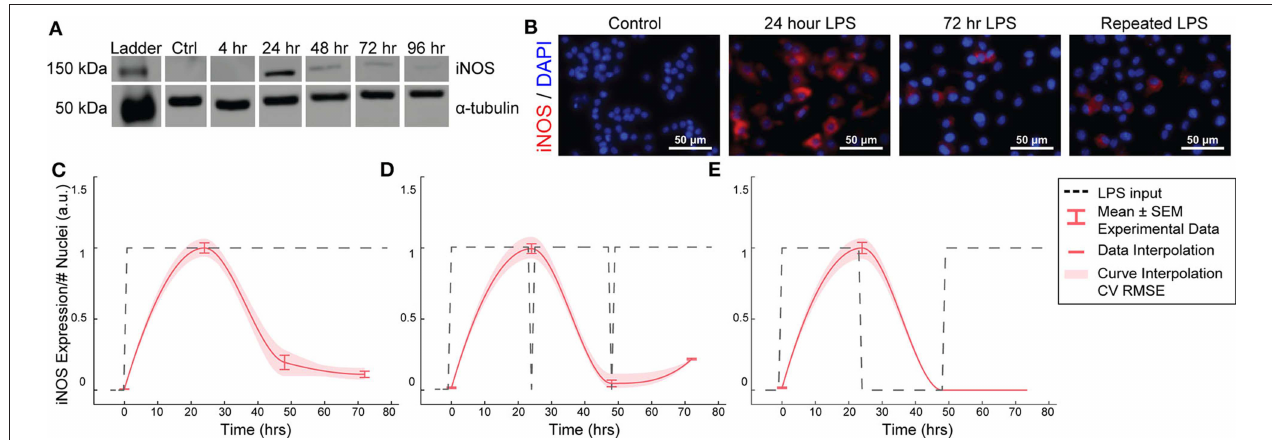
FIGURE 2 | RAW264.7 macrophages transiently express iNOS in response to constant or repeated LPS stimulation. (A) Representative Western blot for iNOS (140 kDa) and α -tubulin (55 kDa) after LPS treatment. (B) Representative ICC images showing iNOS response after LPS stimulation. (C) ICC quantification matches Western blot analysis of transient iNOS expression in response to a single administration of LPS. (D) Dynamics of iNOS expression are not modulated in response to multiple administrations of LPS or (E) after 24h in basal medium before LPS re-stimulation (mean ± SEM, N = 16 at 0, 24, 48, and 72h; red curves; interpolation ± RMS CV